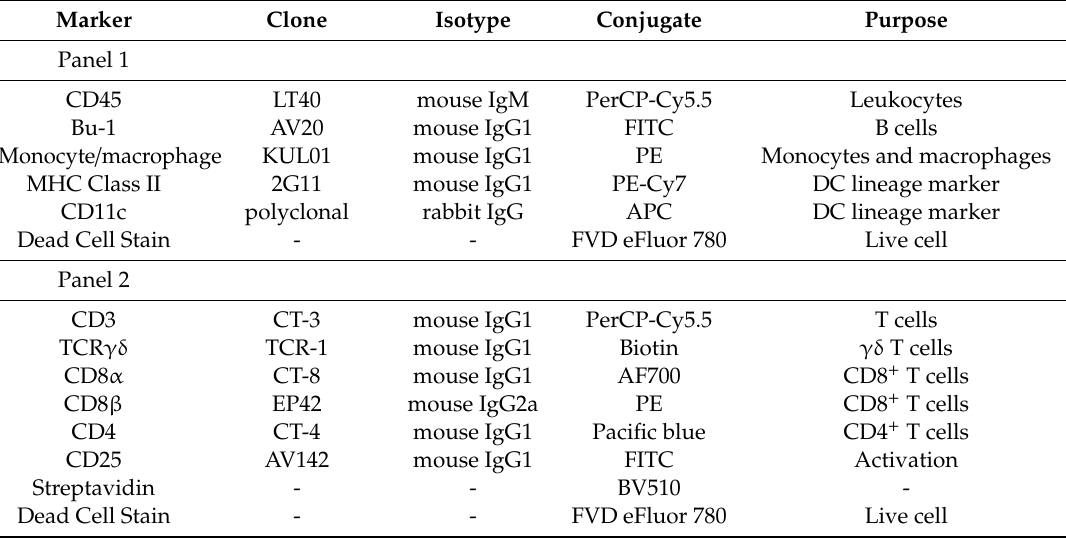
Table 1. Antibodies used for flow cytometry in this